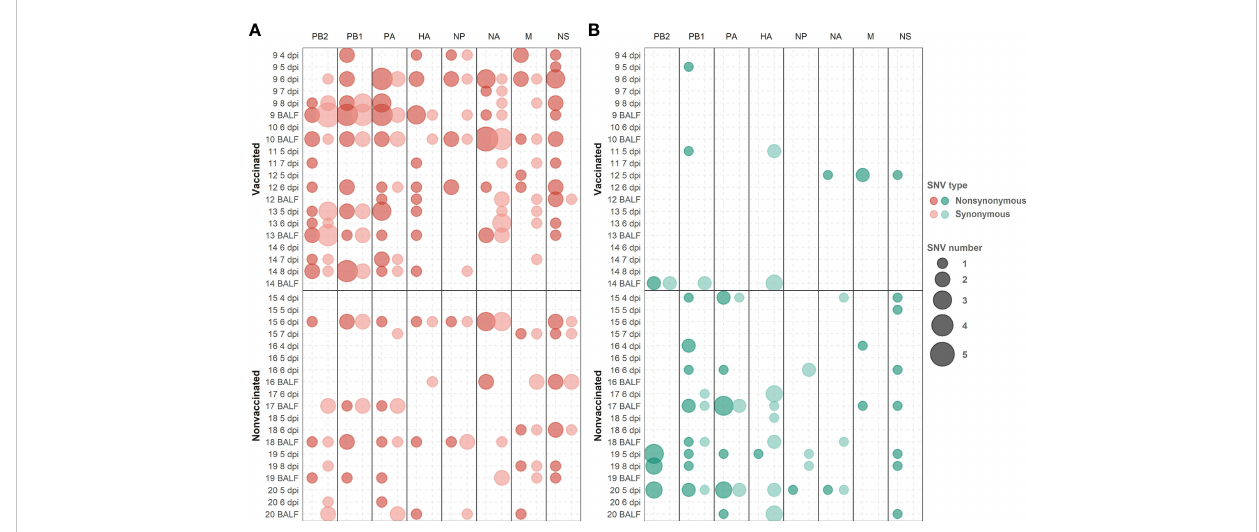
FIGURE 8 De novo synonymous and nonsynonymous SNV with an allele frequency greater than 1% allocation along swine IAV genome. (A) SNVs found in the H1N1 subtype are represented in red circles. (B) SNV found in the H3N2 subtype are indicated in green circles. Nonsynonymous and synonymous substitutions are represented in dark and light colors, respectively. Circle size indicates the total number of SNV found per genomic segment and samples, in abscissa and ordinate axes